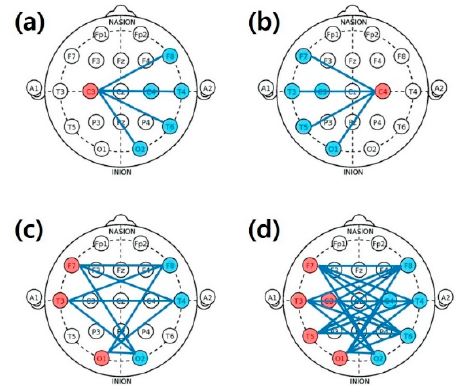
Figure 5. Brain lateralization feature extraction for EEG signal ( a ) 1:5, ( b ) 5:1, ( c ) 3:3, ( d ) 5:5.